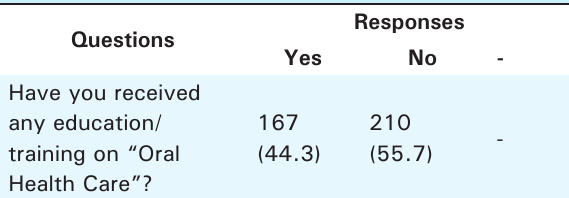
Table 1. Responses of the medical